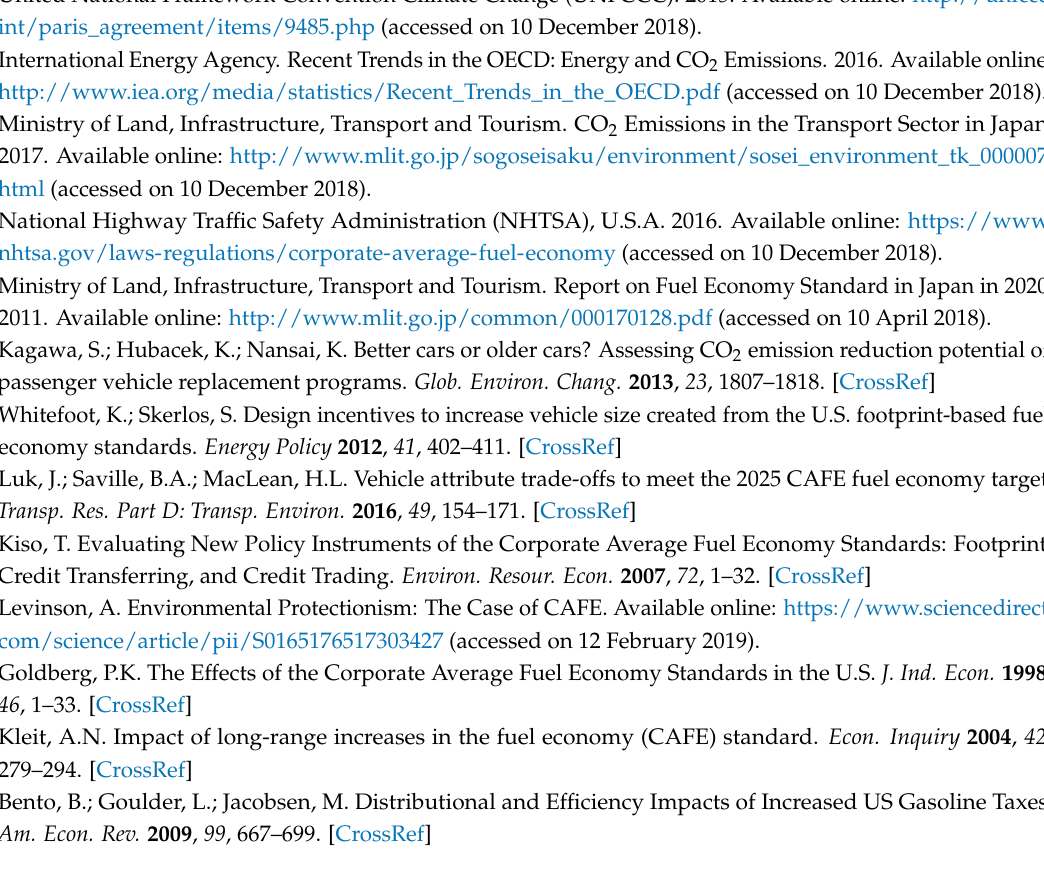
Figure A2. The relationships between fuel efficiency by vehicle model, vehicle weight, and the number of vehicle sales by model for Honda. Table A1. Weight categories.